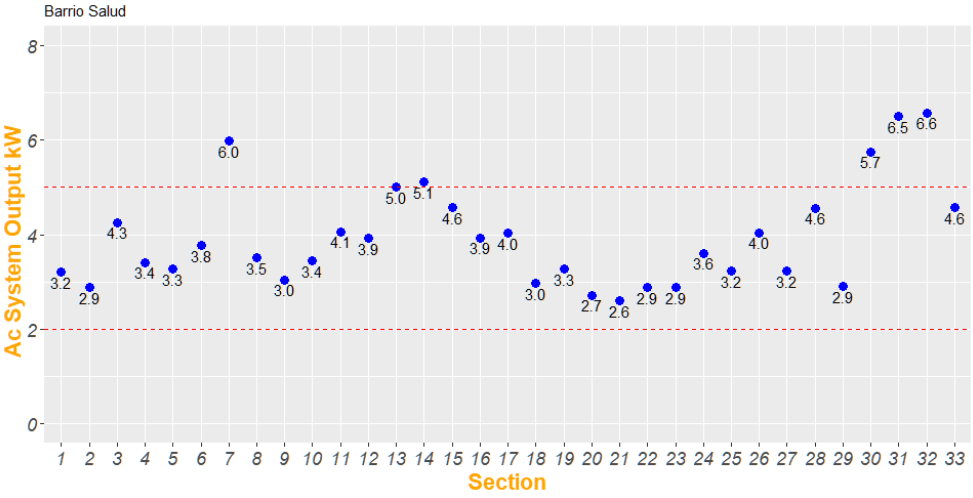
Figure 16. Average daily solar potential estimation of the community for one